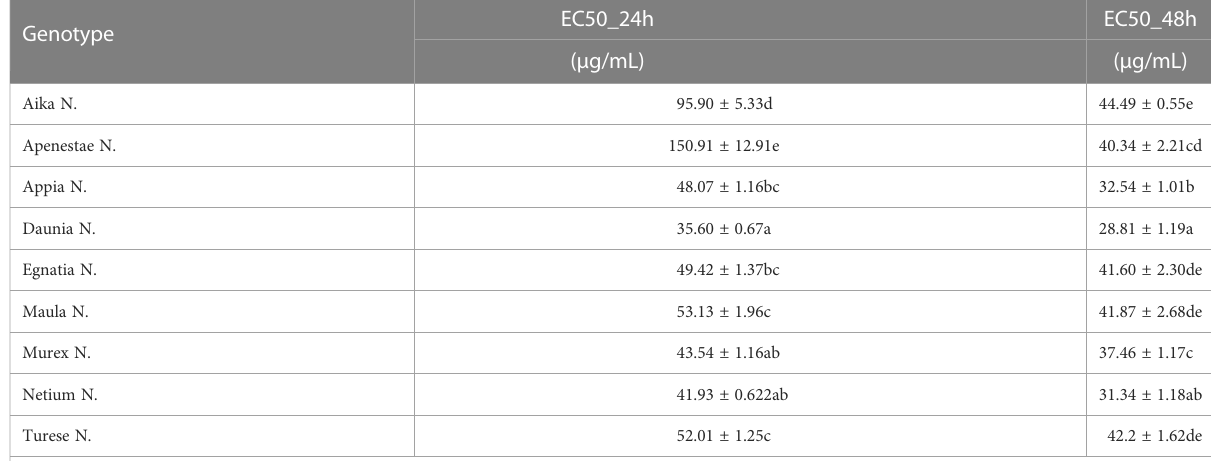
TABLE 2 Antiproliferative activities (EC50 after 24 h and EC50 after 48 h) of the nine new grape genotypes toward the Caco2 cell line.